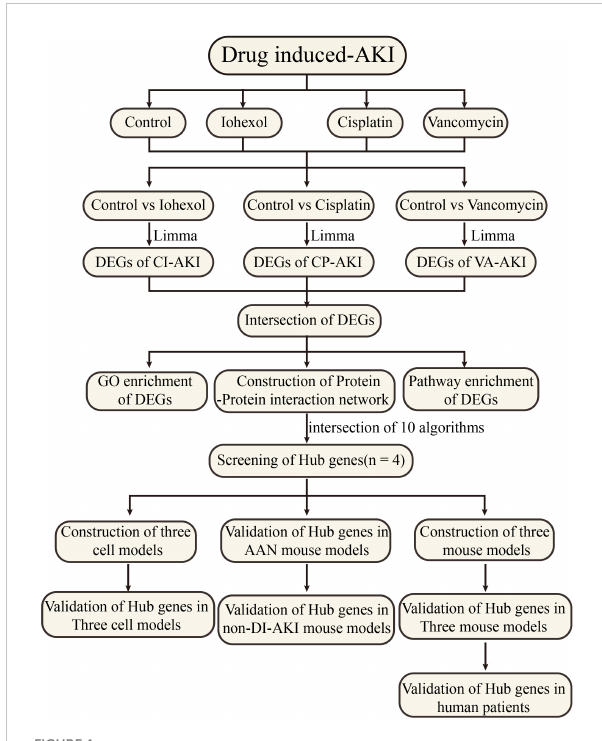
FIGURE 1 Work fl owchart. Limma, linear models for microarray data; DEGs, differentially expressed genes; GSE, gene expression omnibus